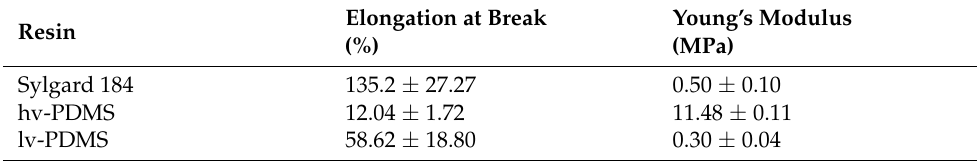
Table 1. Mechanical properties of lv-PDMS, hv-PDMS, and Sylgard 184.